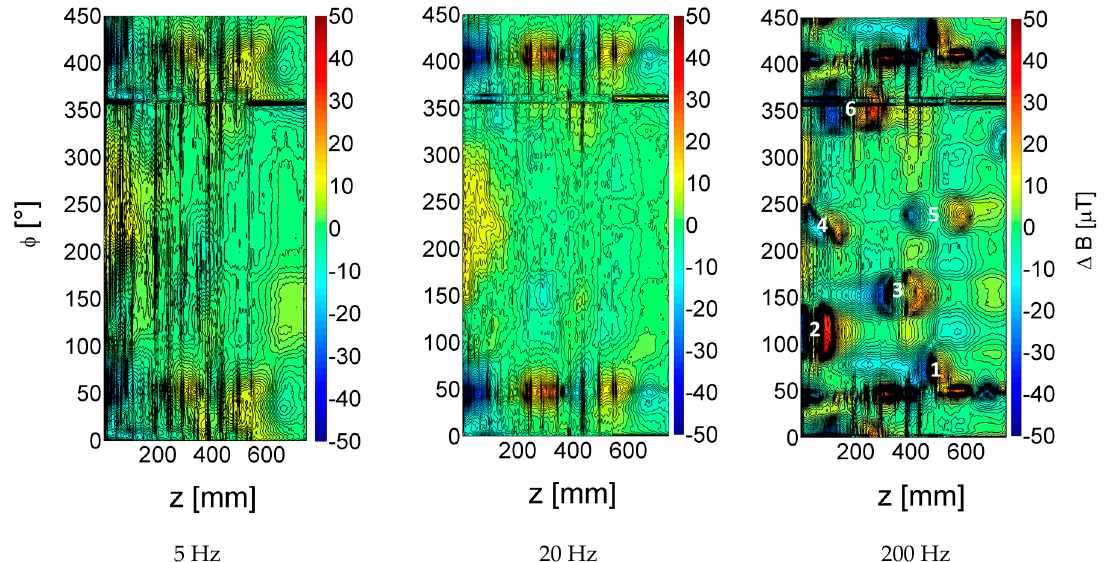
Figure 7. Change in magnetic field amplitude with 6 artificially introduced dents in the weather shield ( r sensor); 5 Hz (left), 20 Hz (middle) and 200 Hz (right) excitation frequency.